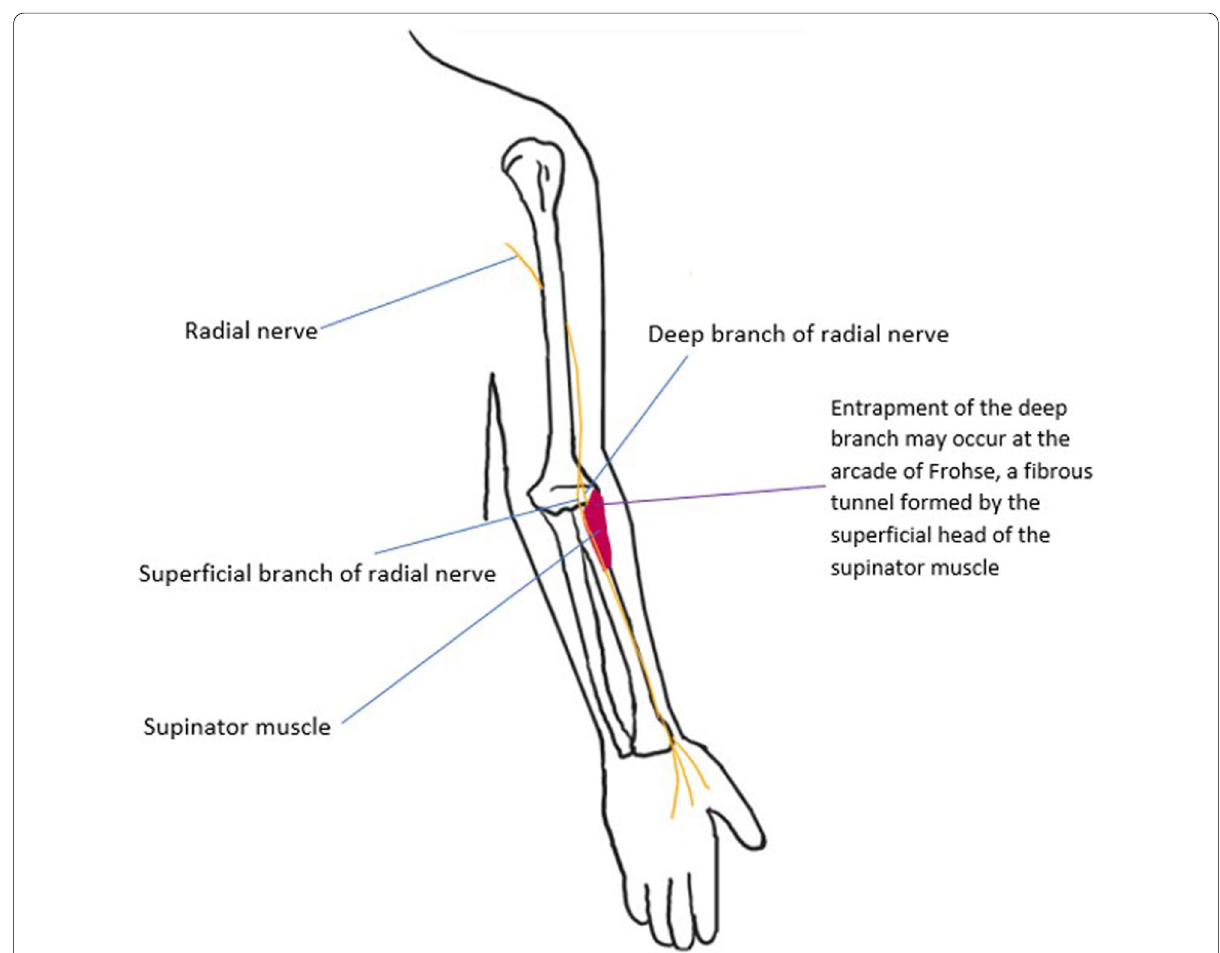
Fig. 6 The radial nerve is shown. The most common entrapment neuropathy of the radial nerve is of the deep branch as it traverses the arcade of